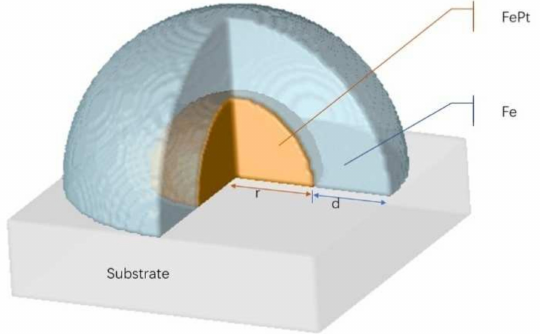
Figure 1. A 3D schematic figure of simulated core-shell structure of FePt/Fe nanocomposite. The FePt core is enveloped by an iron